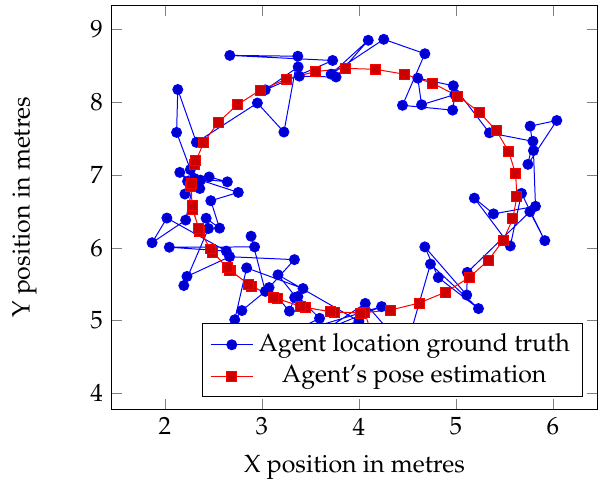
Figure 23. Data of 3D agents position estimation.